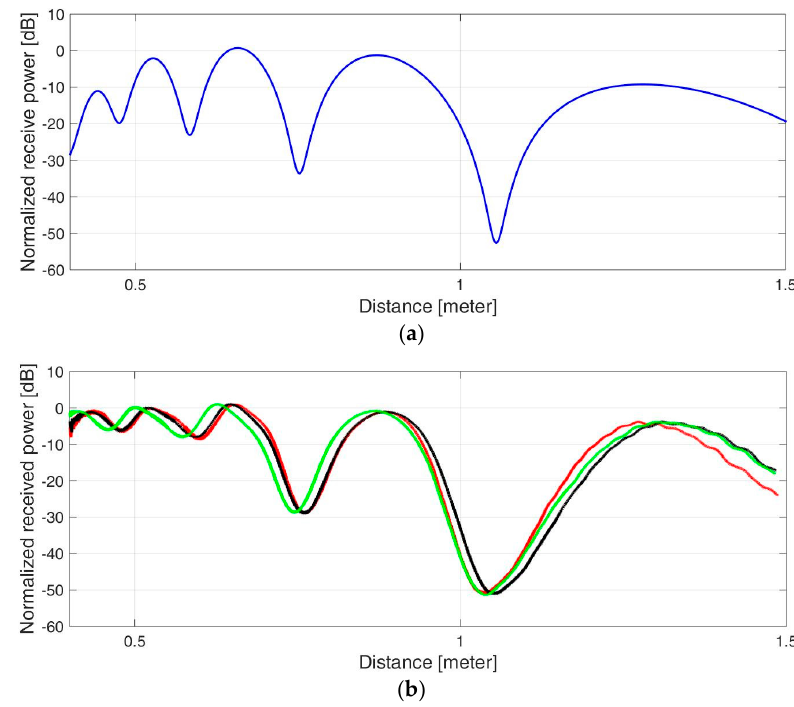
Figure 6. Received power in two-ray model: ( a ) Analytical calculation. ( b ) Experimental results for three similar experiments.